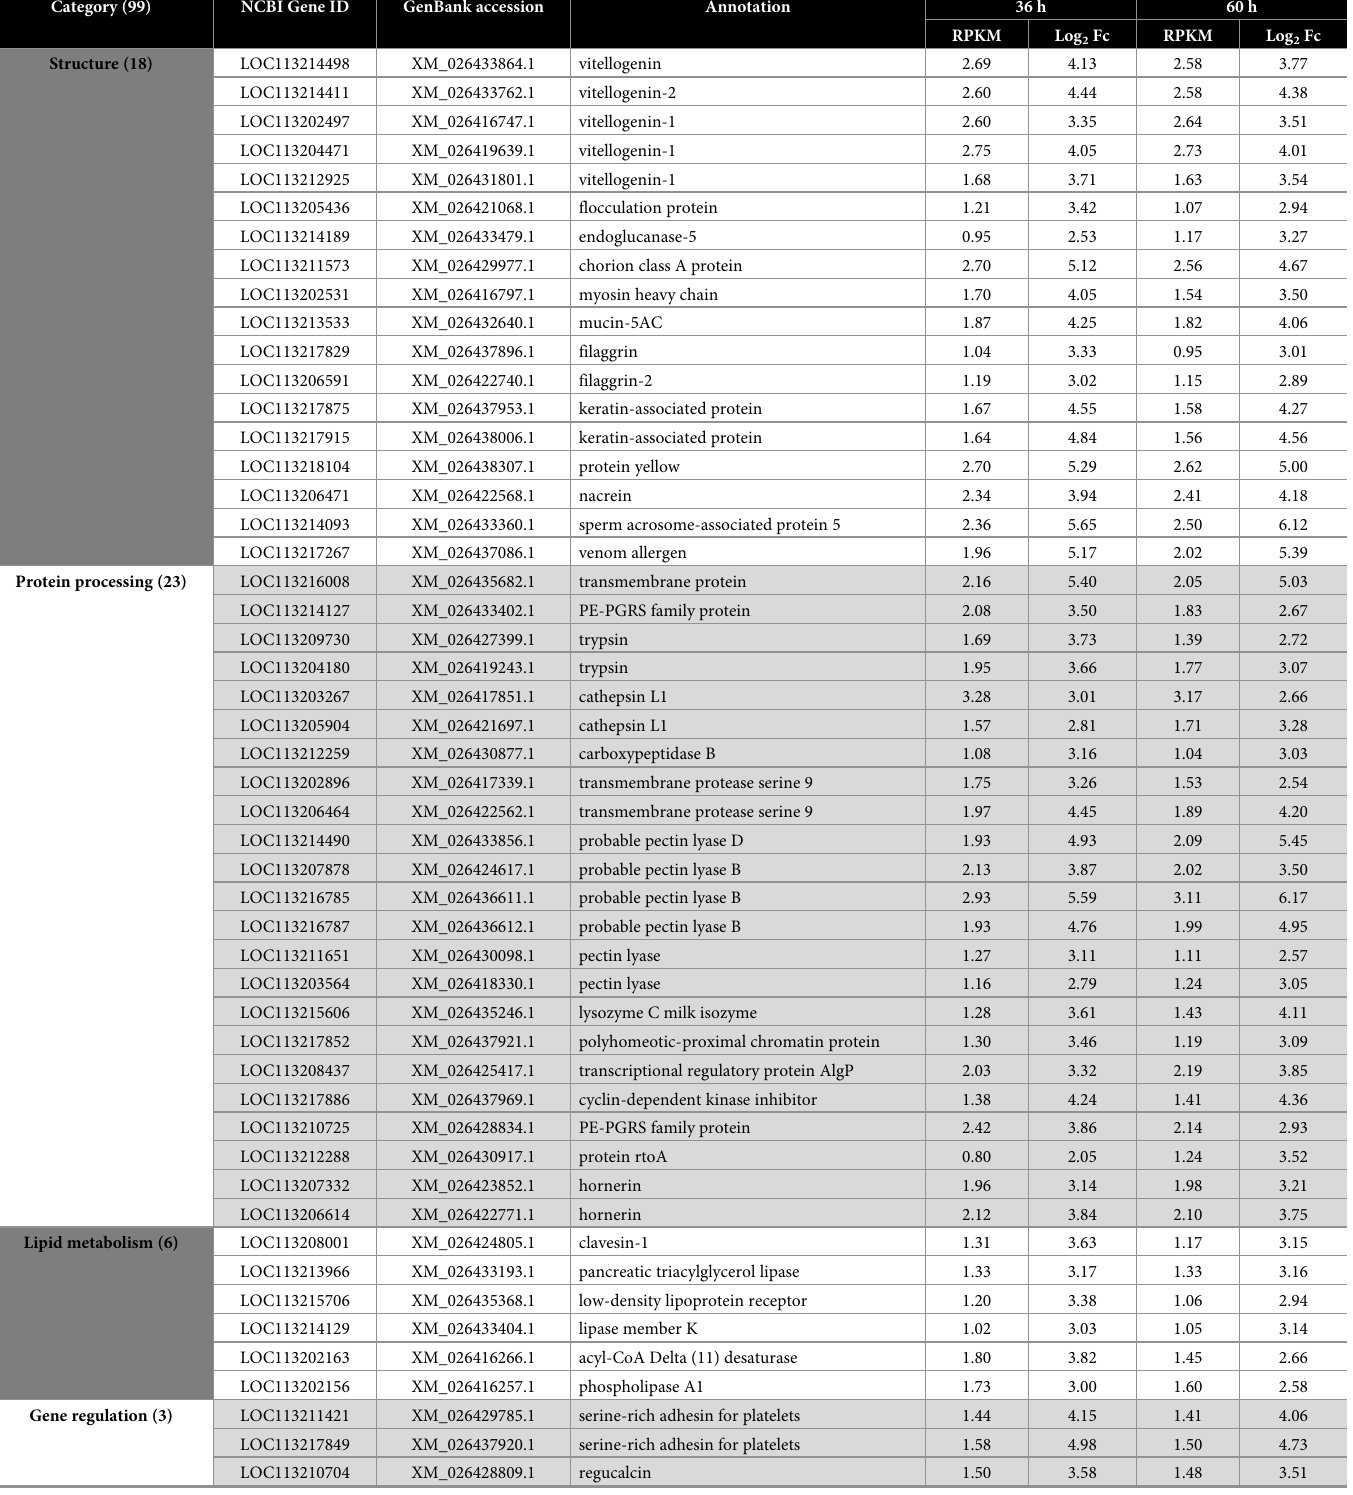
Table 2. Highly ( > 8-fold) expressed genes at mid (36 h after adult emergence) and late (60 h) ovarian development stages compared to expression levels at the early (0 h) developmental stage in female F . occidentalis adults. Category (99) Structure (18)